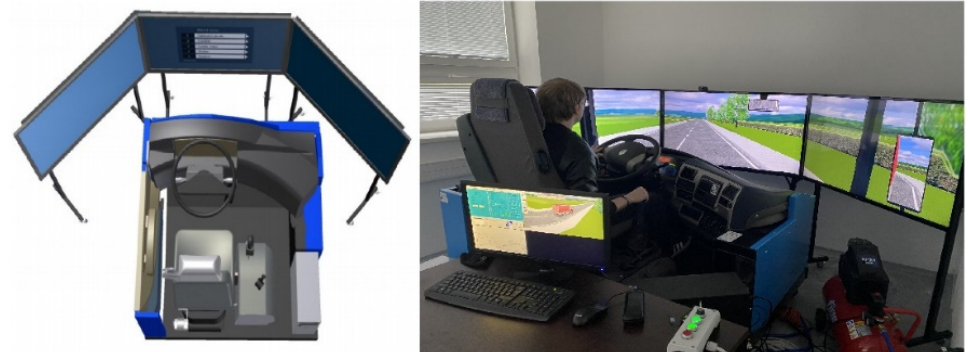
Figure 1. Driving simulator—study design. Source: own collaboration.